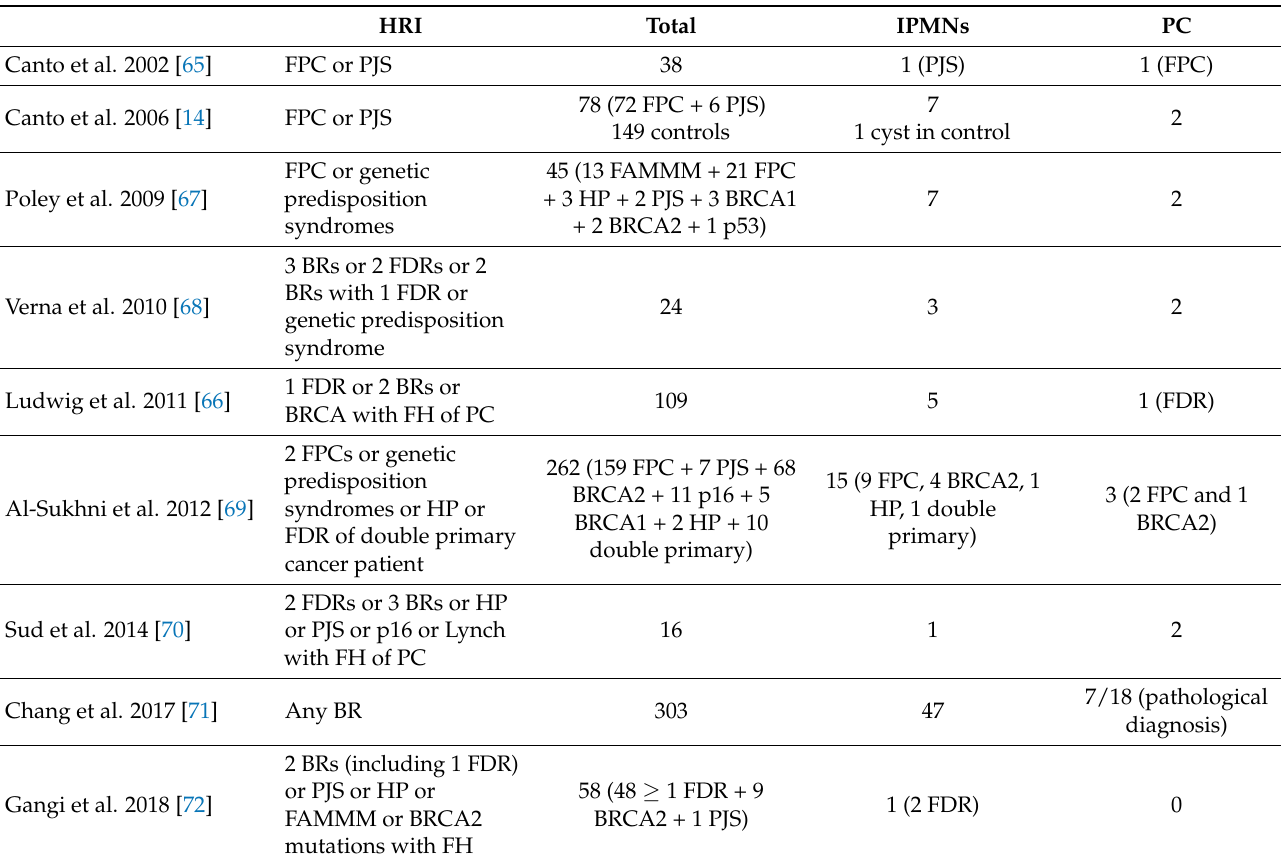
Table 4. The incidence of IPMNs and pancreatic cancer among patients with significant family history of pancreatic cancer. HRI Total IPMNs